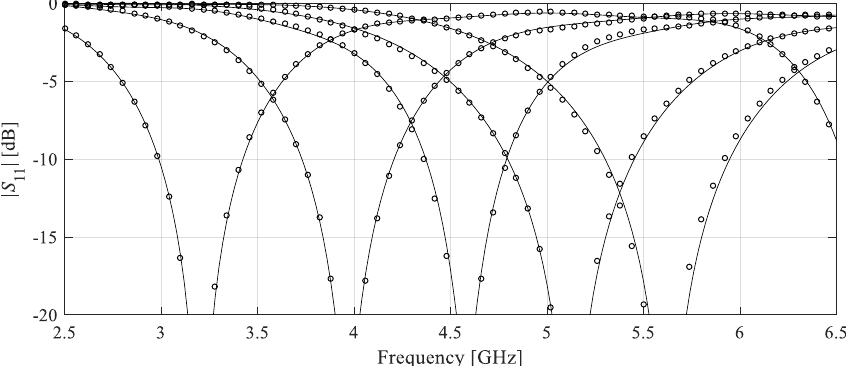
Figure 12. Allocation of the reference designs for the antenna of Figure 11: ( a ) objective space, ( b ) selected three-dimensional projections of the parameter space.